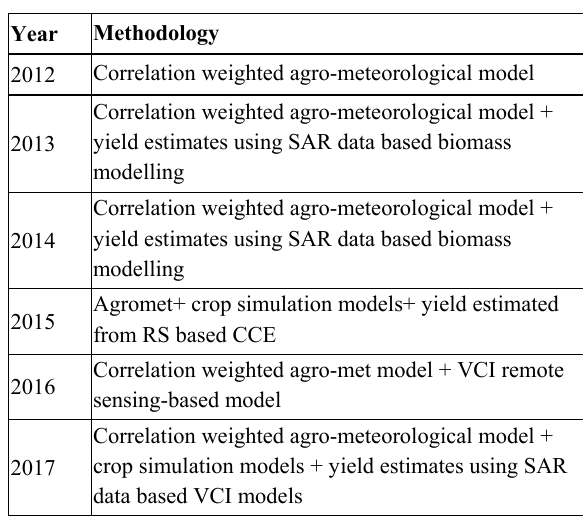
Table3. Different methodologies for yield estimation